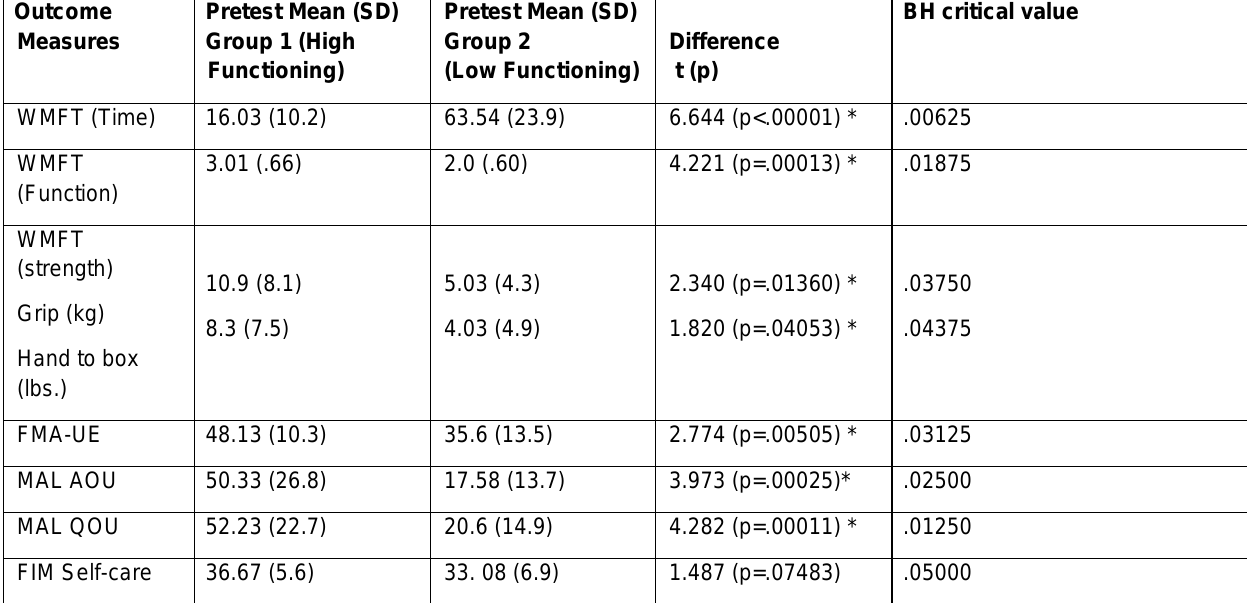
Table 2. Comparison of Pretest Scores for High and Low Functioning Groups